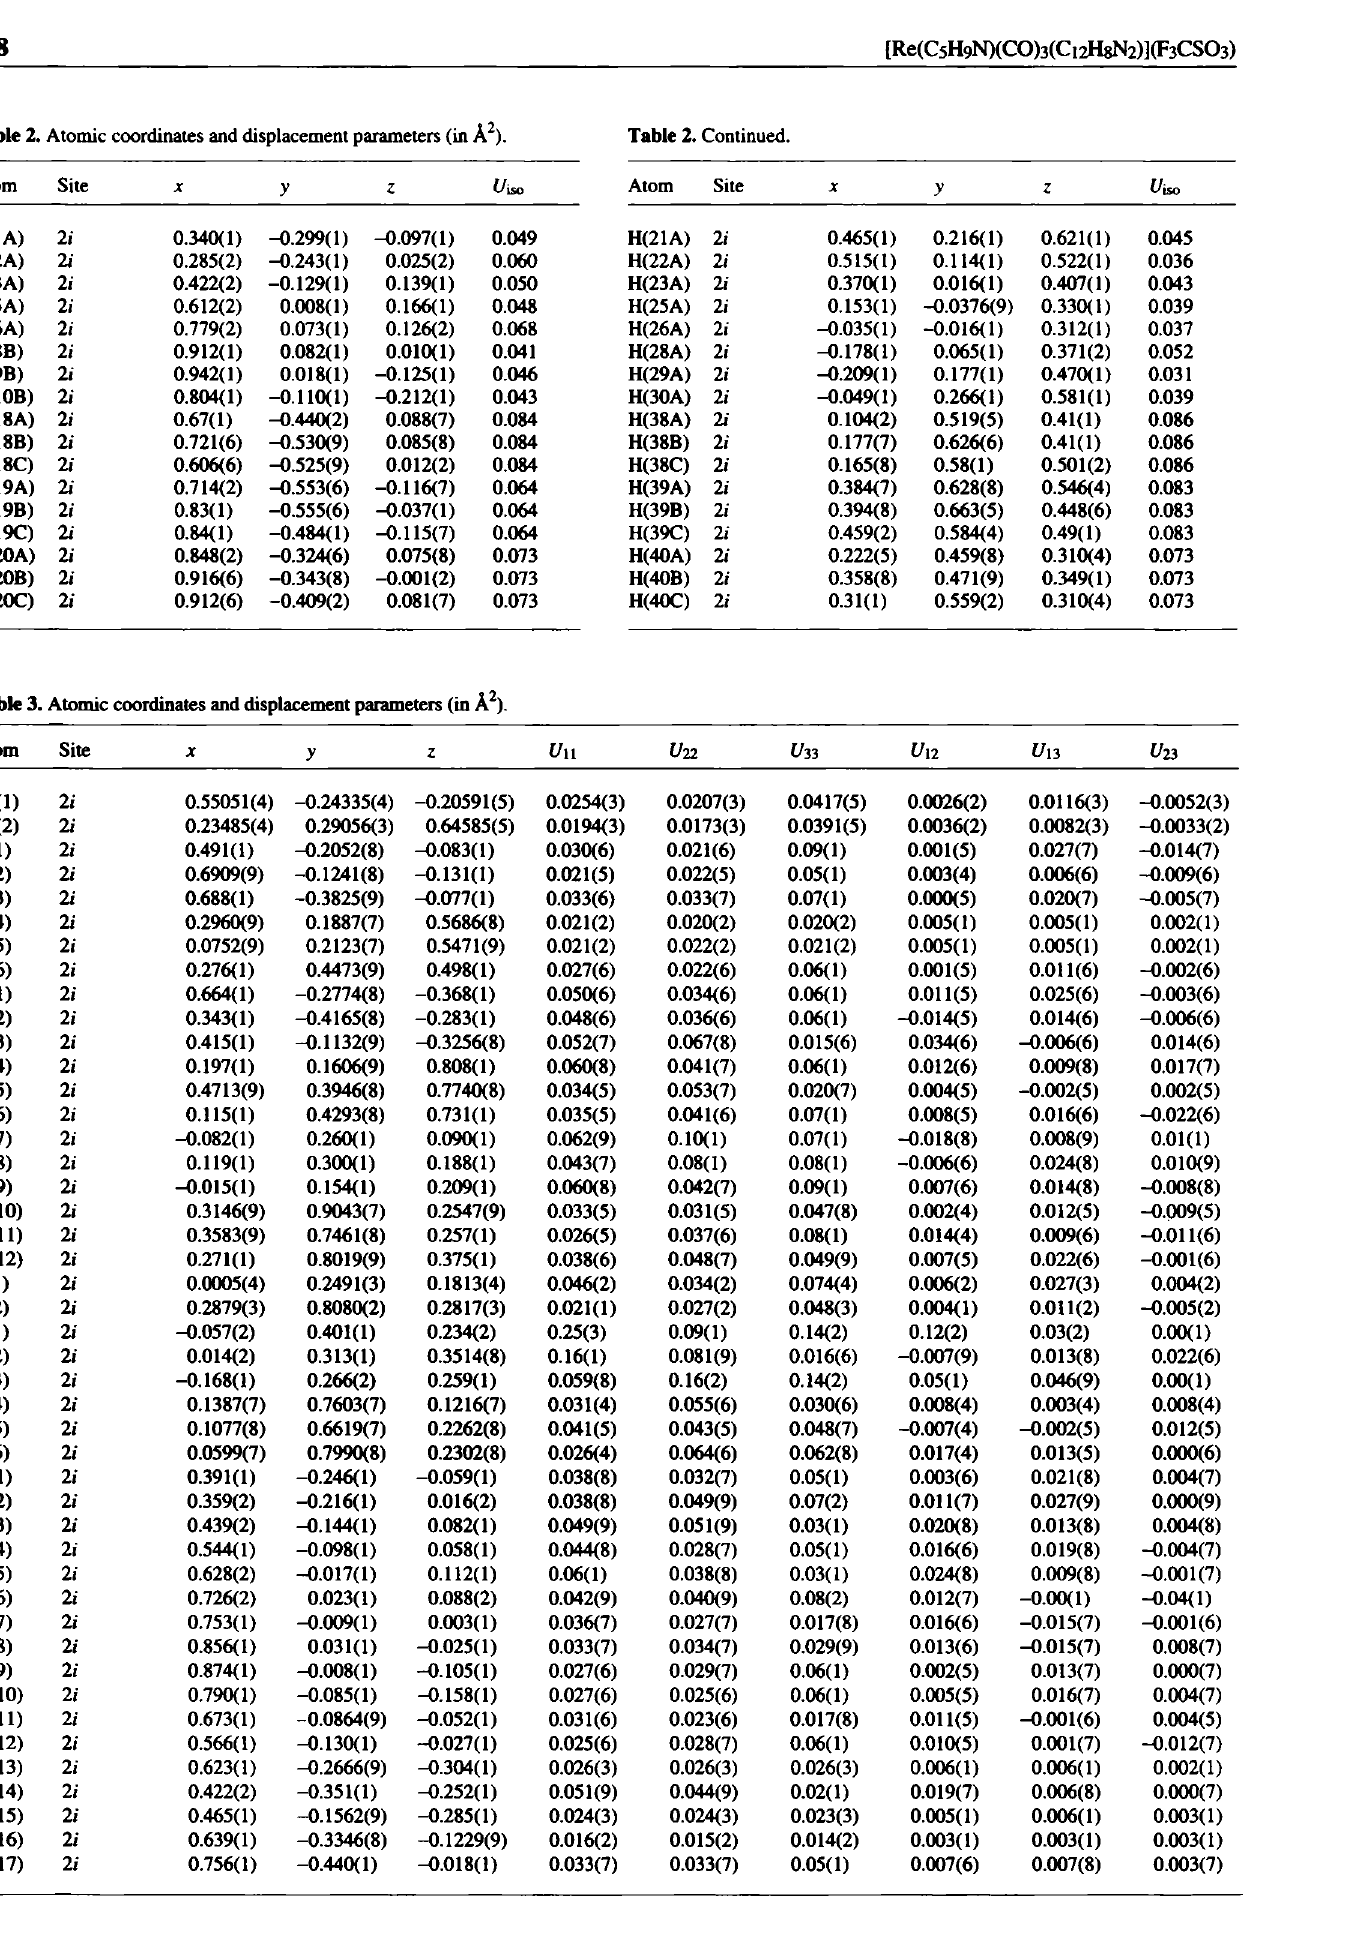
Table 2. Atomic coordinates and displacement parameters (in Ä 2 ).